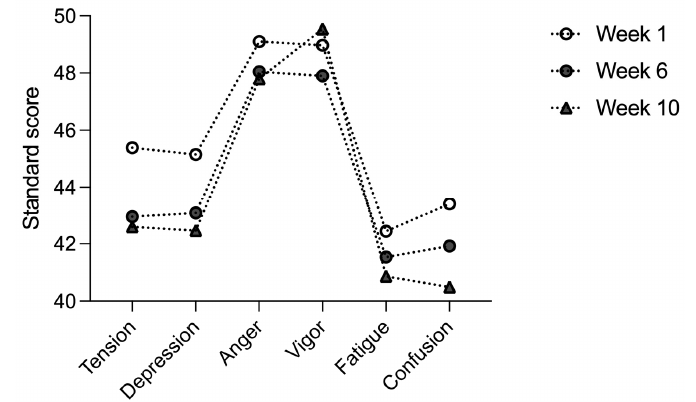
Figure 1. POMS profile of the 3 time